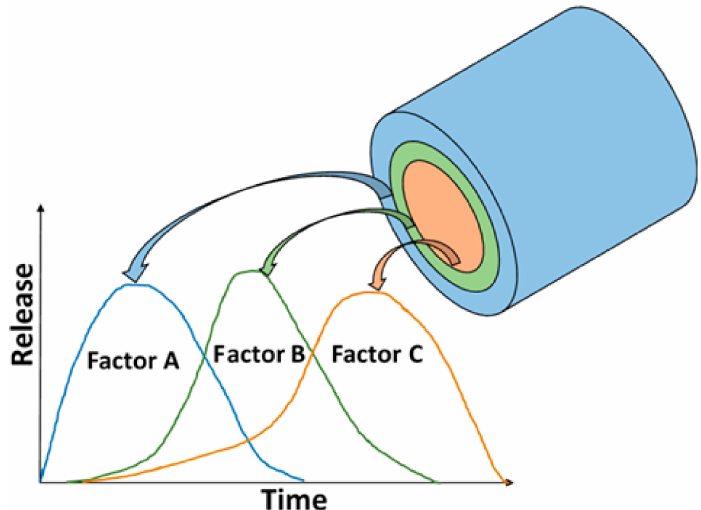
Figure 7. Schematic illustration of layered composite biomaterials with the “smart” sequential delivery of multiple